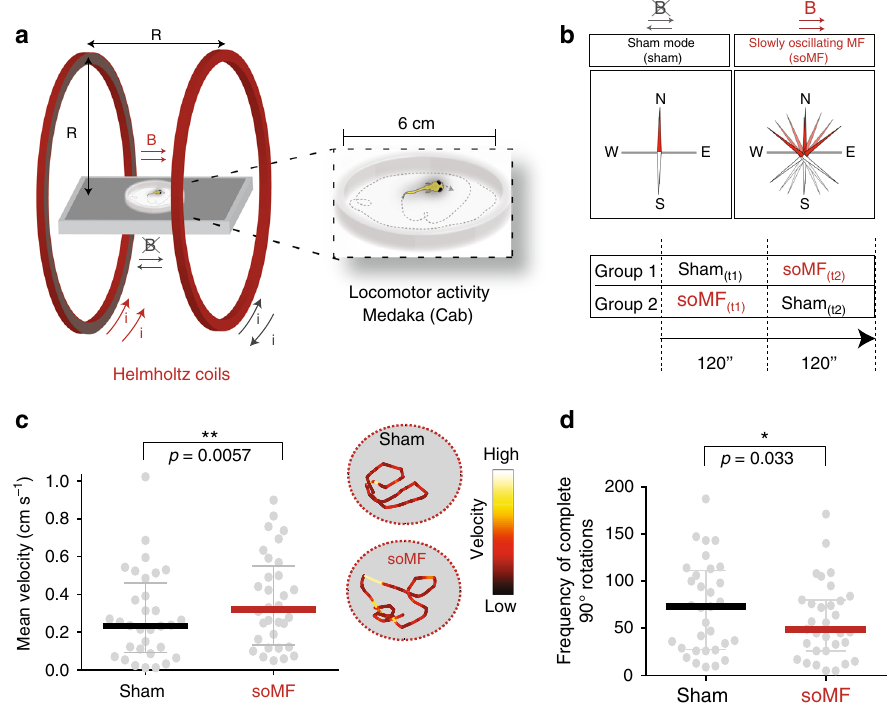
Fig. 3 Juvenile medaka increase their locomotor activity when stimulated with a slow oscillating MF in white light. a , b Schematics of the experimental setup showing the test arena surrounded by double-wrapped Helmholtz coils ( a ) and the experimental conditions ( b ). Control (sham, gray): coils ran with oscillating currents in antiparallel sense resulting in no magnetic fi eld; slowly oscillating MF (soMF, red): coils ran with parallel currents producing an electromagnetic fi eld of 40 μ T oscillating at 1 Hz in the East − West direction, resulting in continuous change of direction and intensity of the magnetic fi eld. Juvenile fi sh explore a circular arena for a total of 240 s (120 s time interval ( t ) for each condition). c , d Graphs showing the increase of the mean swimming velocity ( c , averaged over 60 s before and after the change to soMF), and the decrease of the frequency of complete 90° turns ( d , counted in the 30 s interval before and after the change to soMF) in soMF as compared to the sham condition (control) for juvenile medaka (median and the interquartile range are plotted). On the right side of c , representative swimming trajectories of one individual during both conditions are shown color-coded by velocity. The p values were derived from a two-tailed Wilcoxon signed rank test for n = 32 individual